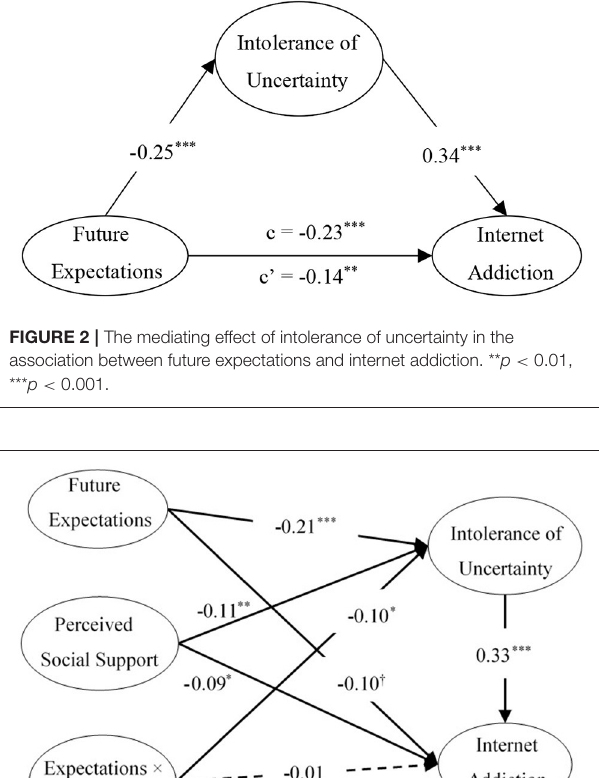
TABLE 2 | Measurement model: latent variable factor loadings.